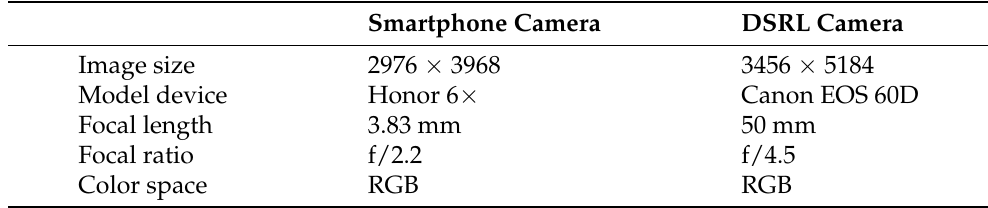
Table 3. Acquisition device